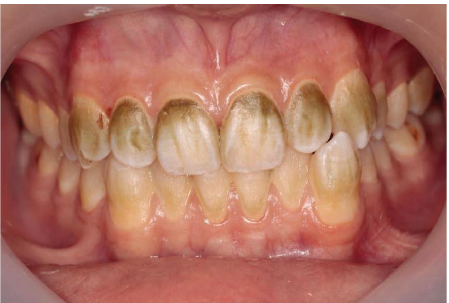
Figure 1: Tooth discoloration caused by occupational exposure to copper in a 15-year-old male patient.